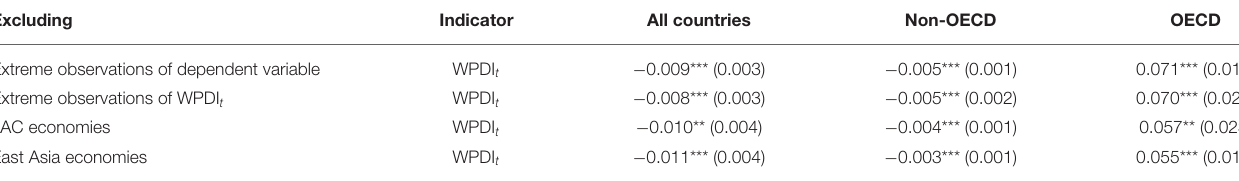
TABLE 7 | Sensitivity Analyses of the Feasible General Least Squares (FGLS) estimations (lagged controls) (1996–2019). Excluding Indicator All countries Non-OECD OECD Extreme observations of dependent variable Extreme observations of WPDI